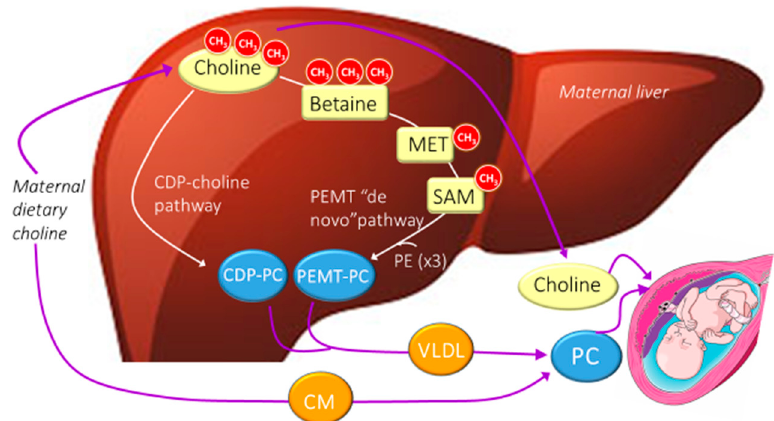
Figure 1. A simplified diagram of the metabolic fate of maternal dietary choline and its delivery to the developing fetus. In the liver, choline can be used to make phosphatidylcholine (PC) through the